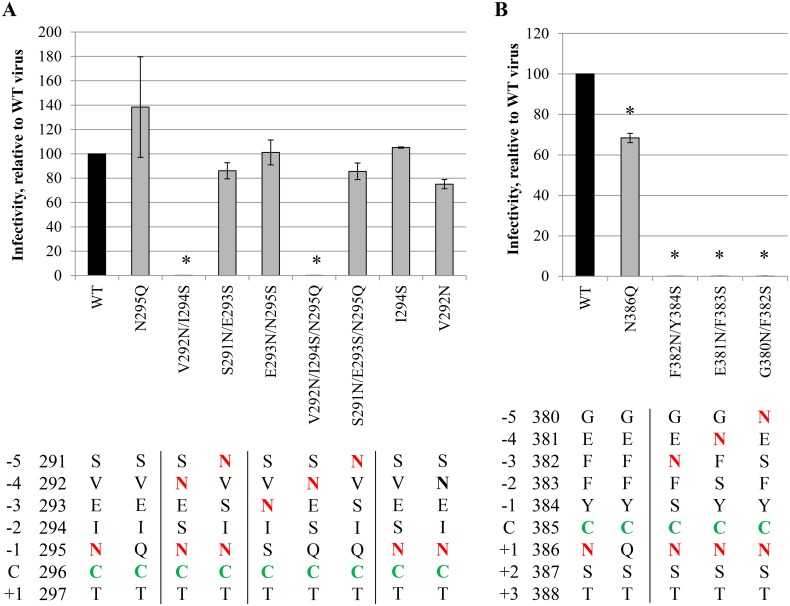
Infectivity of mutant HIV-1NL4.3 strains with N-glycosylation sites introduced in gp120 close to, and upstream of, the disulphide-involved C296 (A) and C385 (B).At day 0, CD4+ T lymphocyte C8166 cells were infected with similar viral loads of WT or mutant virus strains, based on equal amounts of the p24 capsid protein. For 7 consecutive days, samples were harvested, fixed and subjected to flow cytometry to analyse eGFP expression. The infectivity was quantified using a linear regression to part of the obtained eGFP-expression curves, from day 1 post infection to the peak of the curve. Asparagines involved in N-glycosylation sites (N-X-S/T) are coloured red. C296 and C385 are indicated in green. One introduced Asn (V290N) that was not part of an N-glycosylation site is indicated in bold (A). Data are the mean ± SEM of 2–3 independent experiments. The difference between WT and mutant virus was considered to be significant when the p value calculated using the student’s t-test was <0.05 (* = p<0.05).